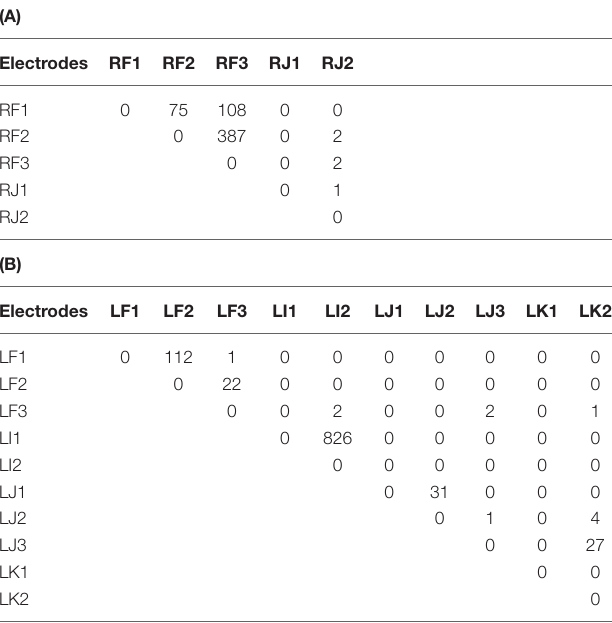
TABLE 4 | The number of DTI tracts between the ipsilateral electrodes are shown.